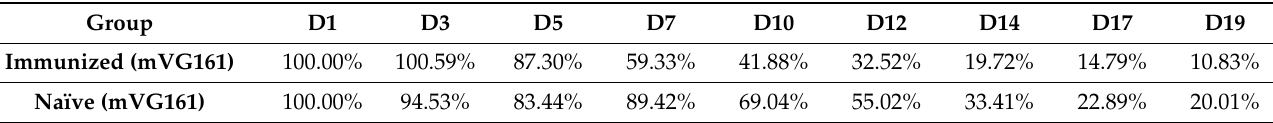
Table 1. Summary of mean ratio of T/C in single-tumor model.